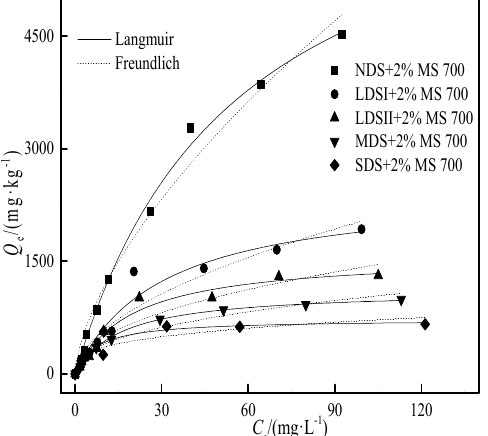
Figure 9. The Cd adsorption of the maize stalk biochar MS 700 in different type of soils.